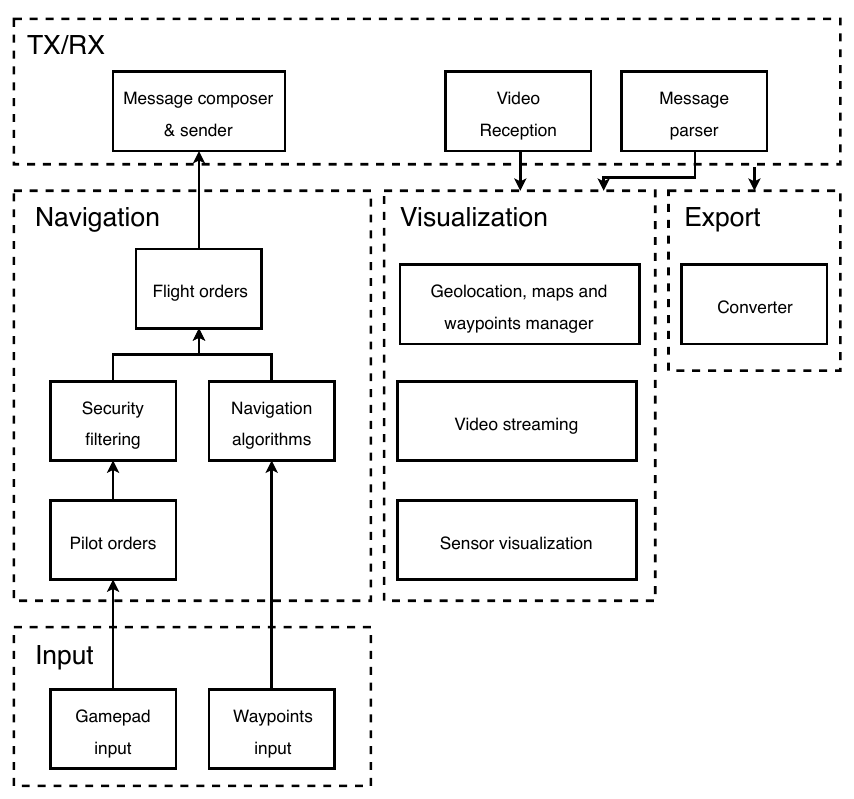
Figure 3. Developed software